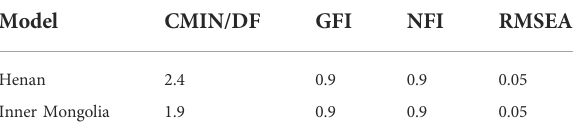
Table 2. In summary, our data indicated that the model was TABLE 2 The model fi t summary.